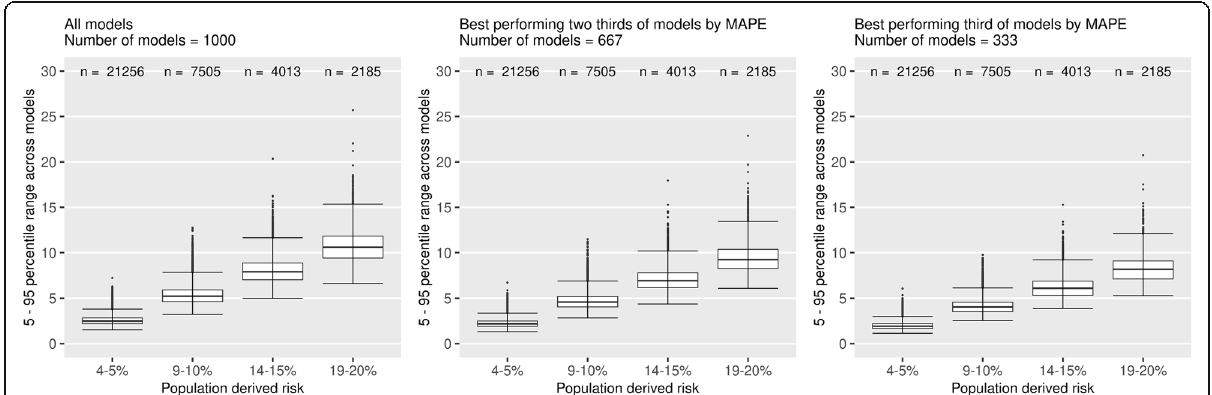
Fig. 5 Percentile ranges of risk for individuals, subsetted by the MAPE practical of the models (female cohort, N = 10000). Each data point represents the 5 – 95th percentile range in risk for an individual across a group models defined by their MAPE practical score. Two thirds of models had MAPE practical < 0.69%, and one third of models had MAPE practical <